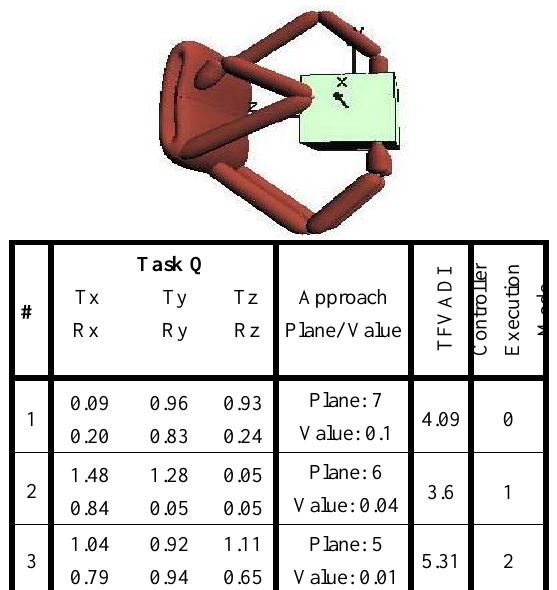
Figure 11. Testing Controller